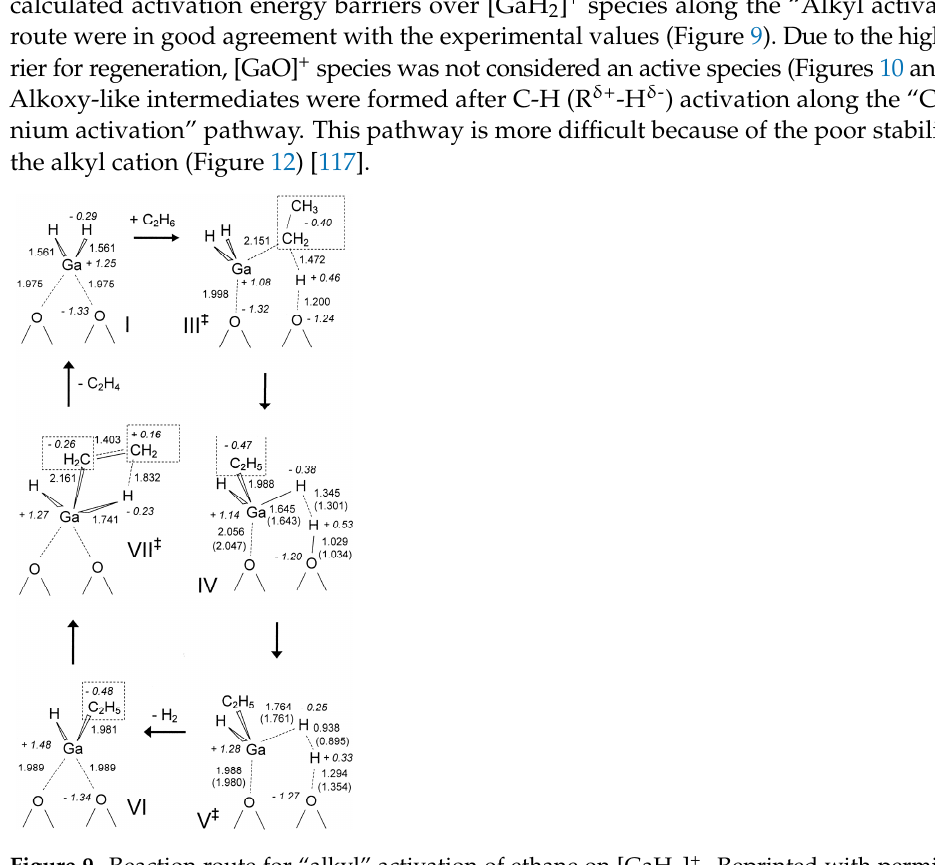
Figure 10. Reaction route for “alkyl” activation of ethane on the adsorbed gallyl ion. Re- printed with permission from ref [117]. Copyright 2000 American Chemical Society.